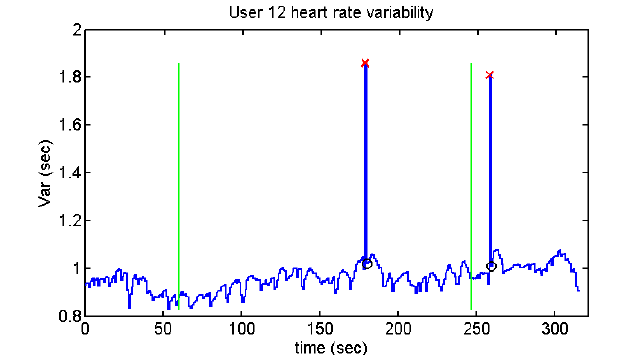
Figure 42. Heart rate variability of User 12 from Sounds